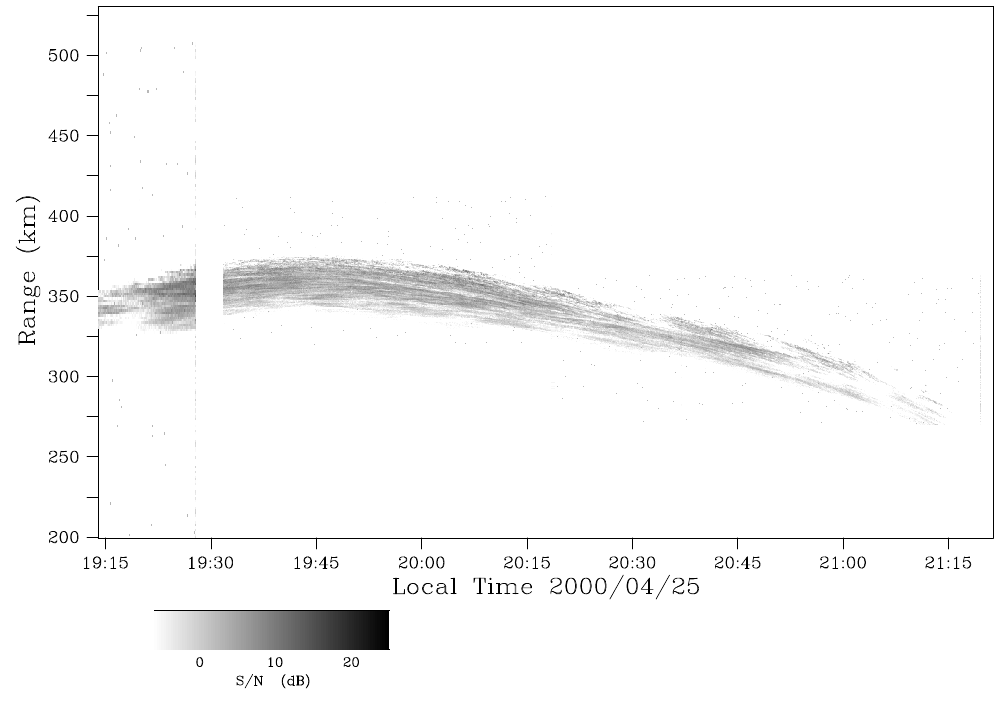
Fig. 1. Range Time Intensity (RTI) representation of a bottom-type scattering layer. Grayscales represent the signal-to-noise ratio on a dB scale. No other F-region irregularities were observed.